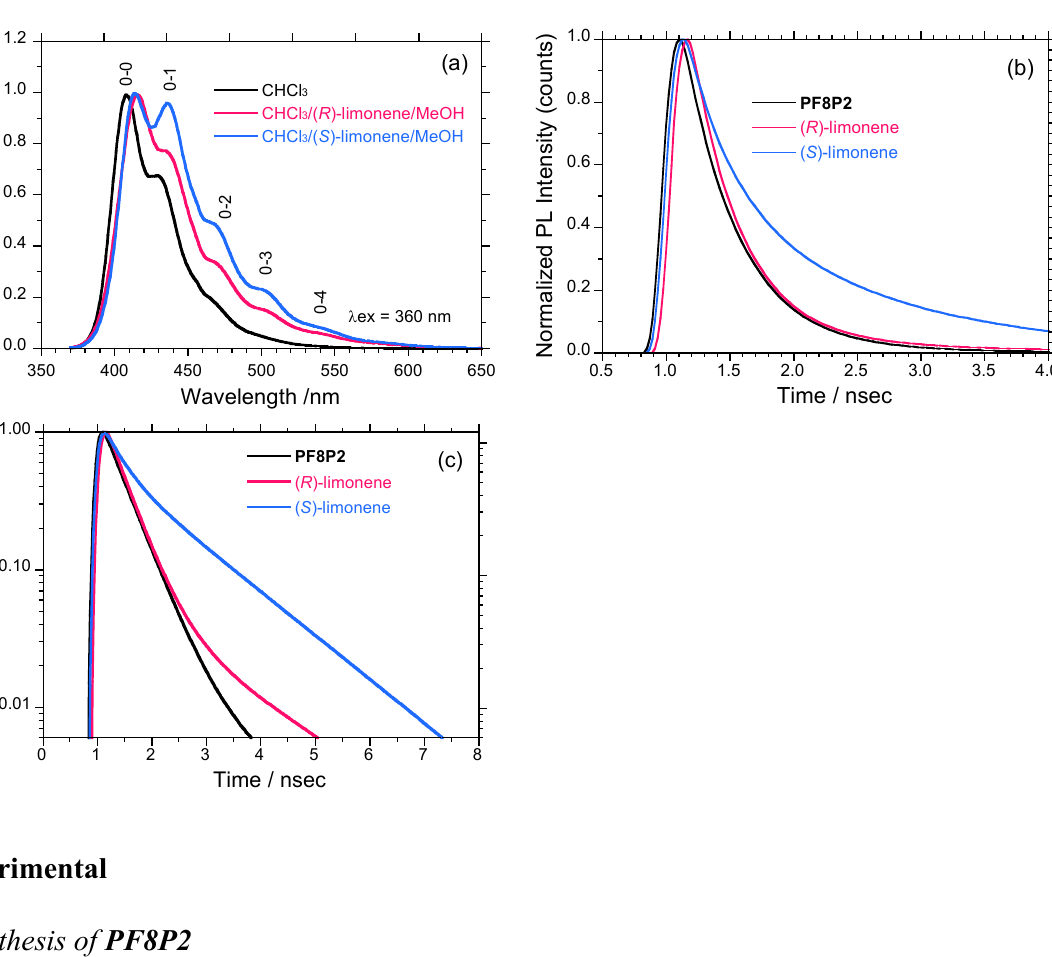
Figure 9. ( a ) Normalized PL spectra excited at 360 nm of PF8P2 (1 × 10 −7 M) in chloroform (black line), PF8P2 aggregates in chloroform/( R )-limonene/methanol (0.3/1.1/1.6 (v/v/v), red line) and PF8P2 aggregates in chloroform/( S )-limonene/methanol (0.3/1.1/1.6 (v/v/v), blue line). ( b ) and ( c ) PL decay curves (excited at 360 nm) collected at 380–420 nm of PF8P2 and aggregates as a function of time. The ordinates are plotted as (b) linear and (c) log